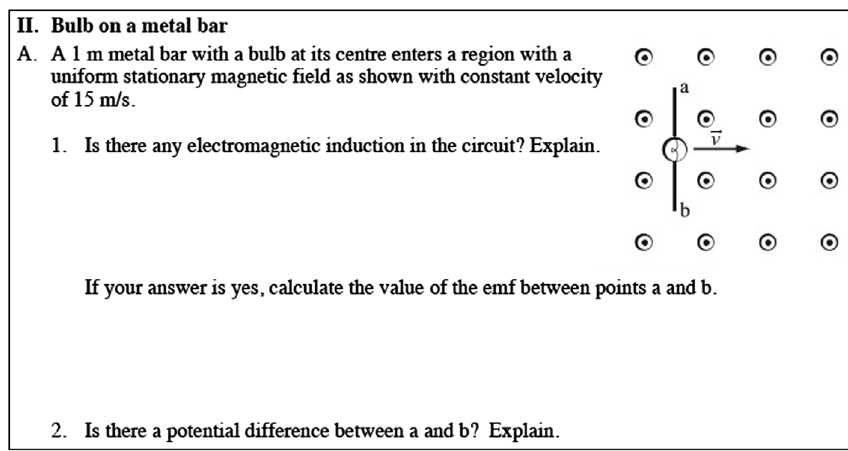
FIG. 4. Activity A.3.2 where the cause of emf is motional. In this case, because the circuit is open the emf generated sets up a potential difference due to charge separation between points a and b